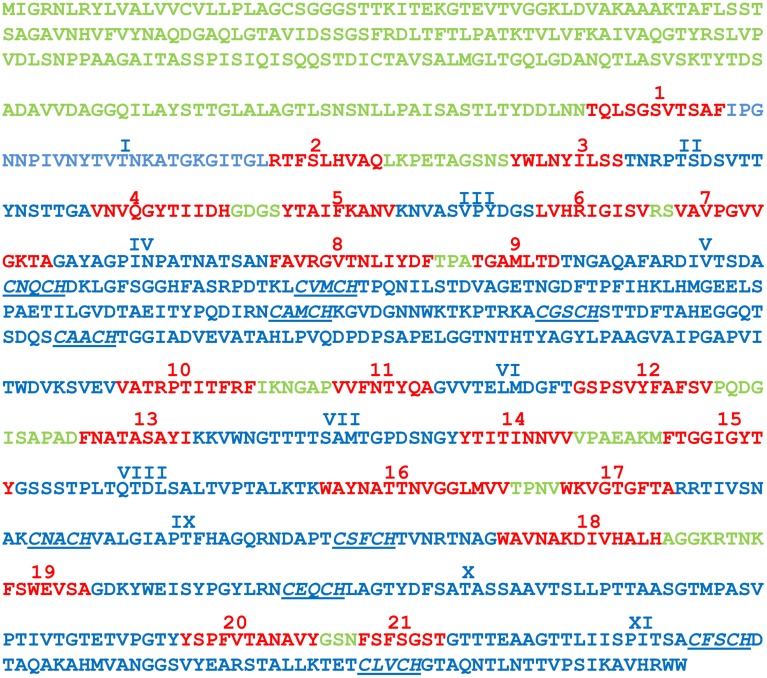
The amino acid sequence of GM18_3465 of Geobacter sp. M18. The N-terminus and predicted short solvent-exposed loops are in green, the predicted trans-outer membrane motifs are in red, and predicted long solvent-exposed loops are in blue. The 21 trans-outer membrane motifs are numbered sequentially and the numbers are displayed in red and Arabic numerals and above the amino acid sequence. The long solvent-exposed loops are numbered sequentially and numbers are displayed in blue and Roman numerals and above the amino acid sequence. The heme-binding motifs are underlined and in italic.